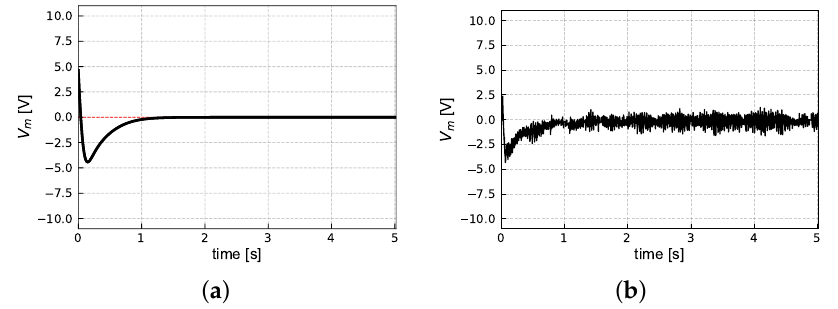
Figure 16. Case C2: Input signal: ( a ) simulation, ( b )